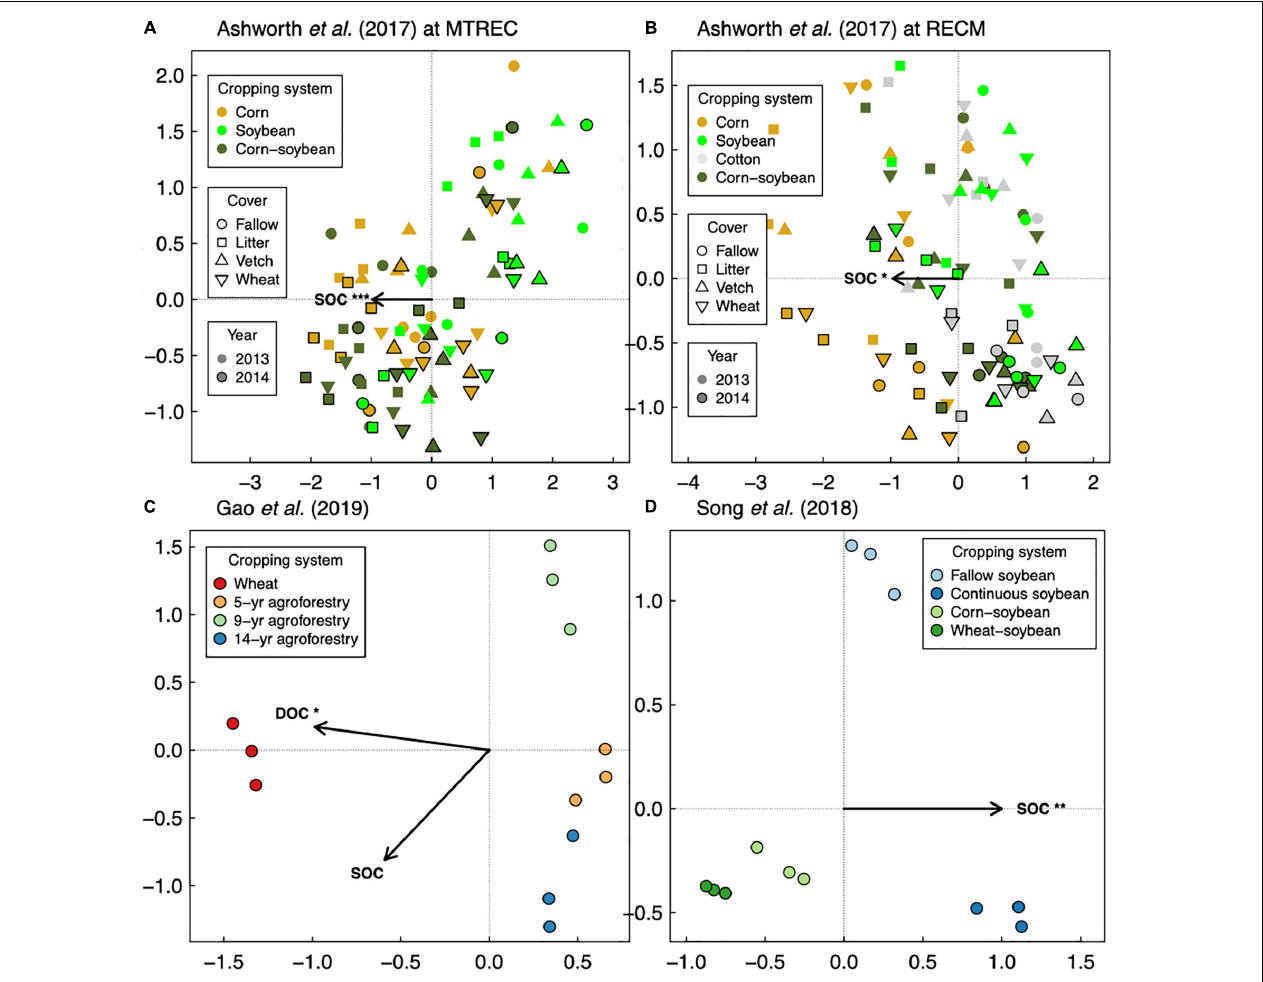
FIGURE 4 | Distance-based redundancy analysis of soil bacterial communities in response to soil organic carbon (SOC), with readily available SOC pools shown if data were available as dissolved organic carbon (DOC). Three studies are represented: Ashworth et al. (2017) (A,B) , Gao et al. (2019) (C) , and Song et al. (2018) (D) . Asterisks represent significance of marginal treatment effects (*** p < 0.001, ** p < 0.01, * p <